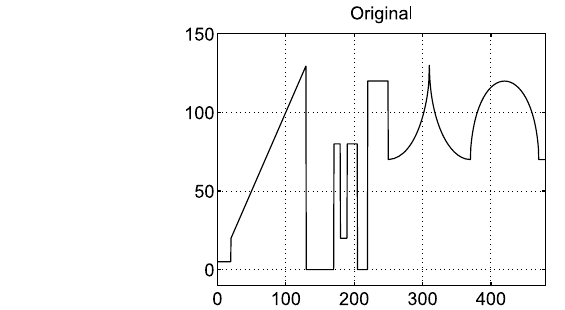
Figure 1 1-D original